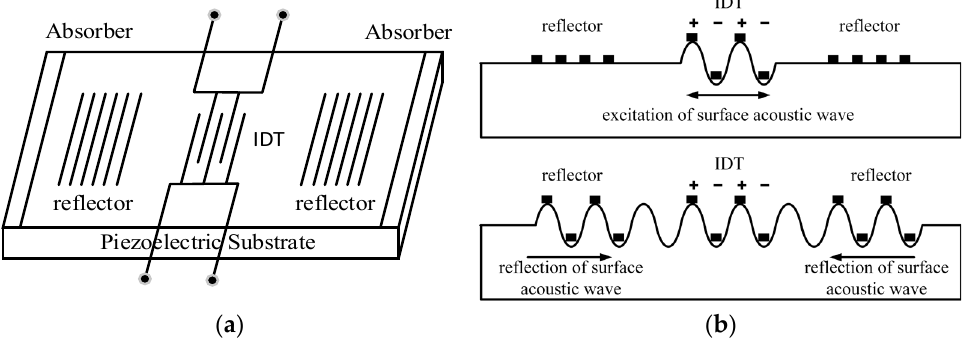
Figure 1. SAW device unit structure ( a ) one-port resonant type; ( b ) Propagation mode of SAW.